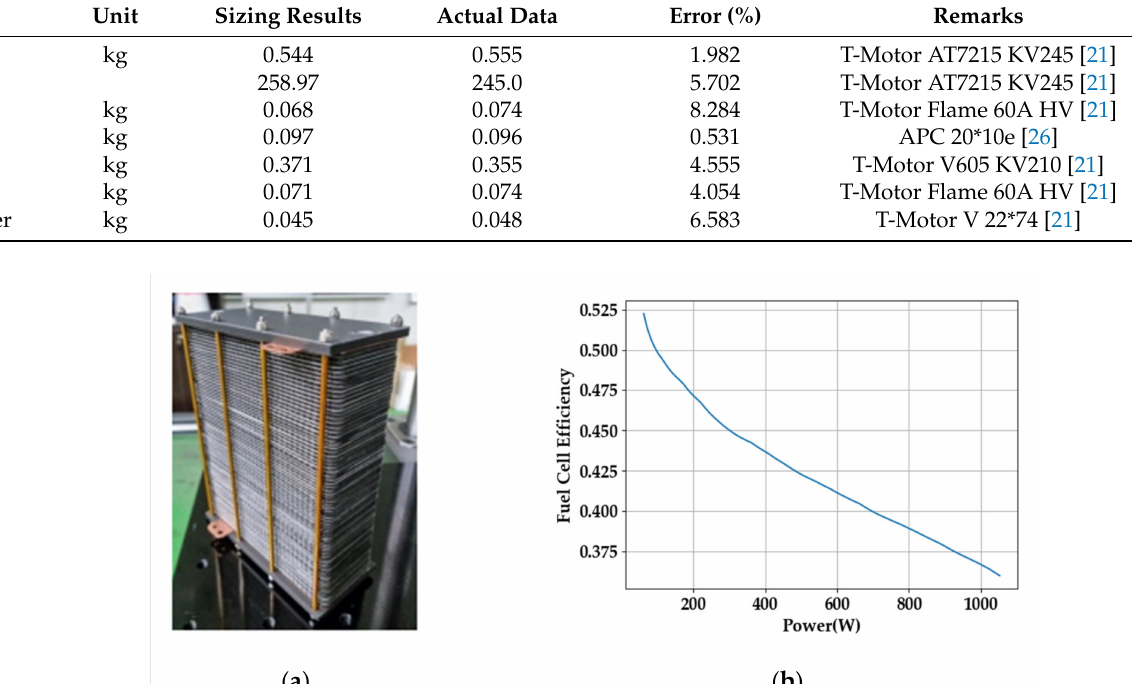
Figure 18. ( a ) Nexcoms HFC [38] and the ( b ) efficiency of HFCs according to the HFC’s operating power, which is one of the results of sizing.